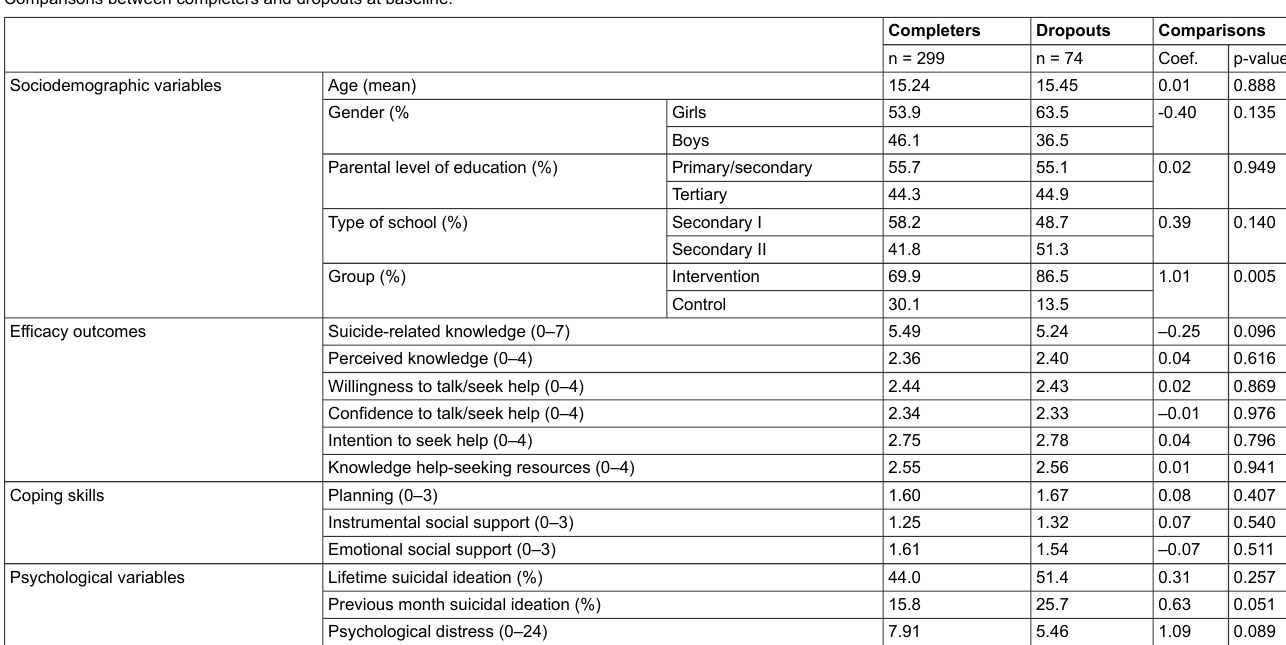
Table 2: Comparisons between completers and dropouts at baseline.